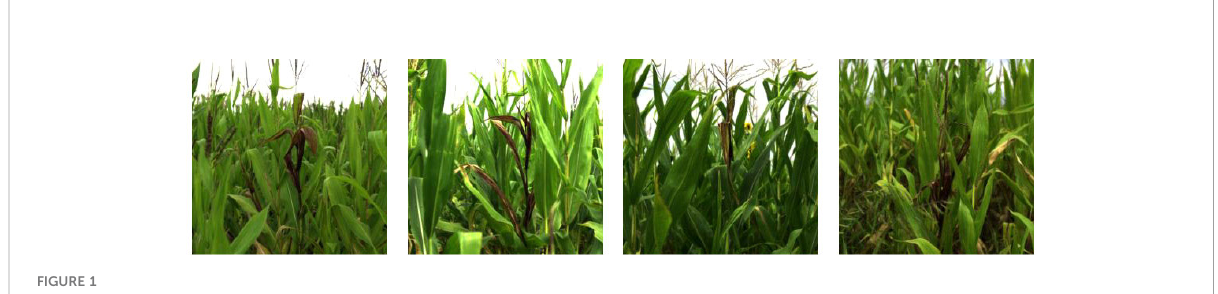
FIGURE 1 Part of maize samples in